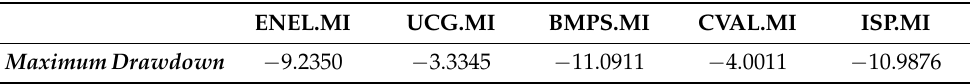
Table 4. ENEL.MI, UCG.MI, BMPS.MI, CVAL.MI, and ISP.MI. Maximum Drawdown (%)